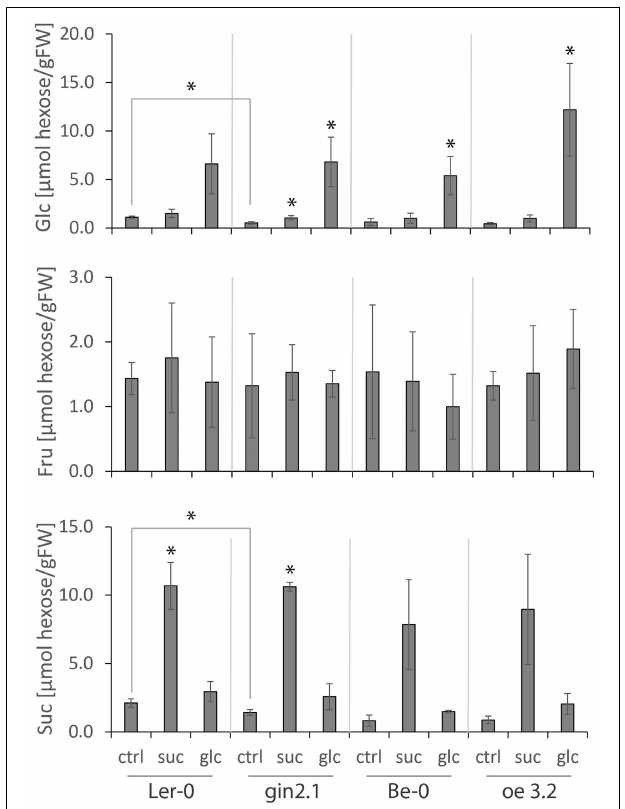
FIGURE 6 | Effects of short (1 h) exposure to external Glc or Suc on internal sugar contents in shoots of A. thaliana wt plants and HXK1 -transgenics ( gin2.1 mutant and oe3.2 overexpressor). The A. thaliana seedlings were grown for 7 days in liquid media under a 16h light/8h dark photoperiod, followed by a 24h dark treatment. Subsequently the seedlings were dipped for 1h either into water, 1% Glc or 1% Suc, and the samples were collected for sugar content analyses. The star indicates significant difference either between untreated wt and gin2.1 mutant or between untreated and treated samples. Significance: t -test; * α = 0 . 05 , n = 3 .